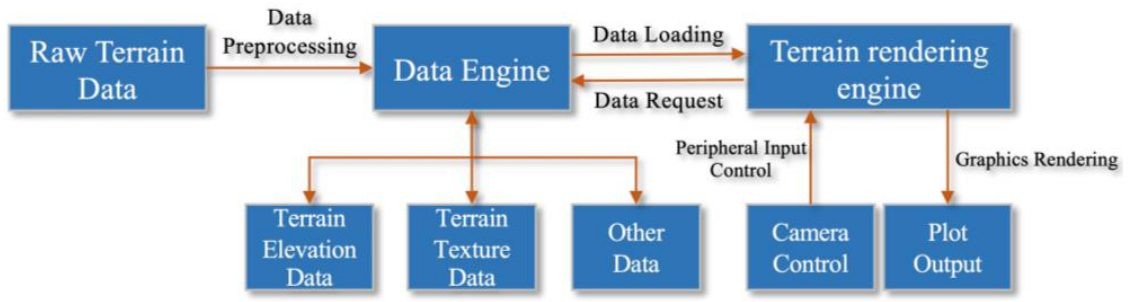
Figure 4. Framework for submarine 3D terrain simulation.